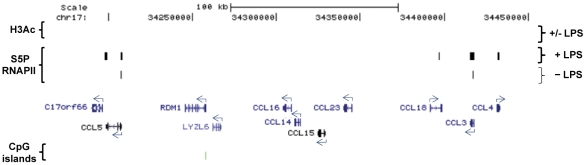
Overview of the human CCL cluster.The CCL chemokines cluster is an example of a genomic region lacking any significant H3Ac peaks. It is also a region with a low presence of CpG islands. The significant up-regulated genes of the cluster, CCL4 and CCL18, contain S5P RNAPII binding. Genes identified by RefSeq using the UCSC browser are shown with blue arrows indicating TSSs locations and directions (GRCh37/hg19).